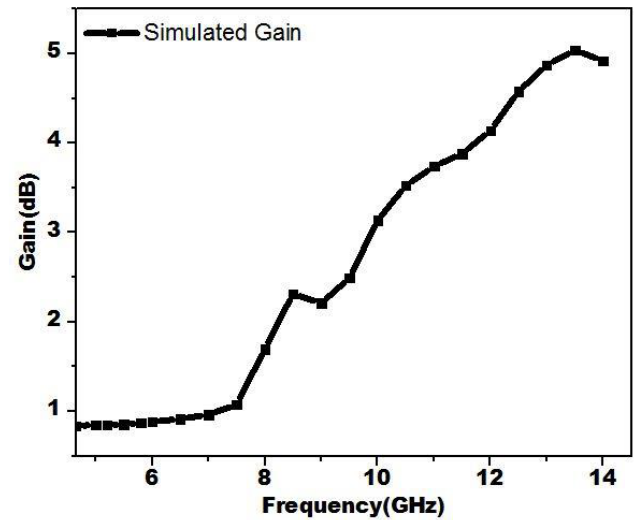
Figure 32. Simulated Gain.